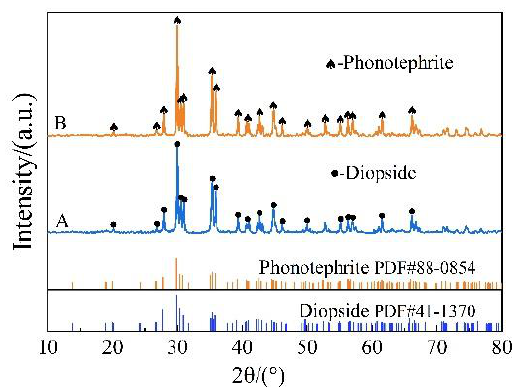
Figure 2. DTA curve of base glass.